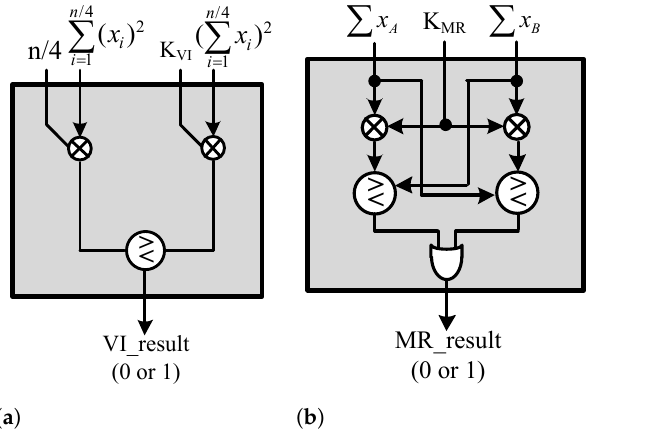
Figure 17. Hardware architecture of EDU.